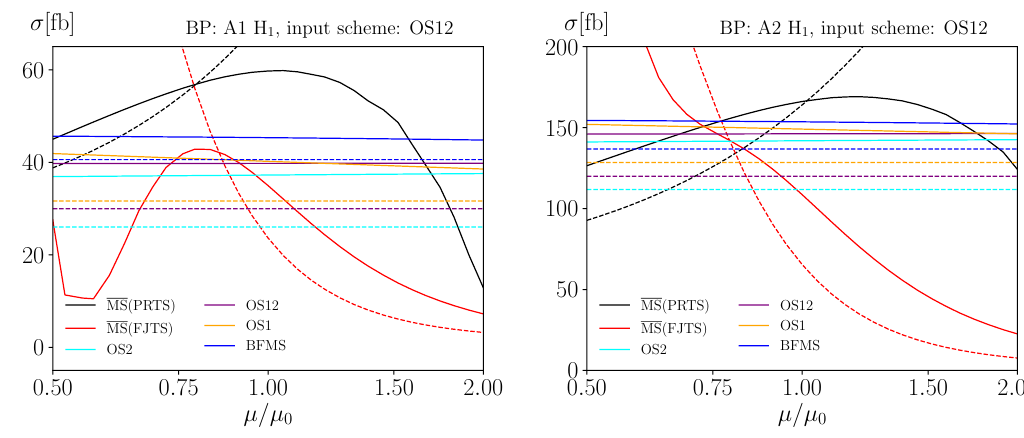
Figure 7 . Scale dependence for heavy-Higgs-boson production in Higgs-strahlung, pp X , for the THDM benchmark scenarios A1 (left) and A2 (right) in di(cid:11)erent renormalization schemes, with the OS12 scheme as input scheme (and full conversion of the input parameters into the other schemes). LO results are shown as dashed, NLO as full lines; the central scale is set to (cid:22) 0 = ( M H + M H + M A + 2 M ) = 5. H + 2 1 0